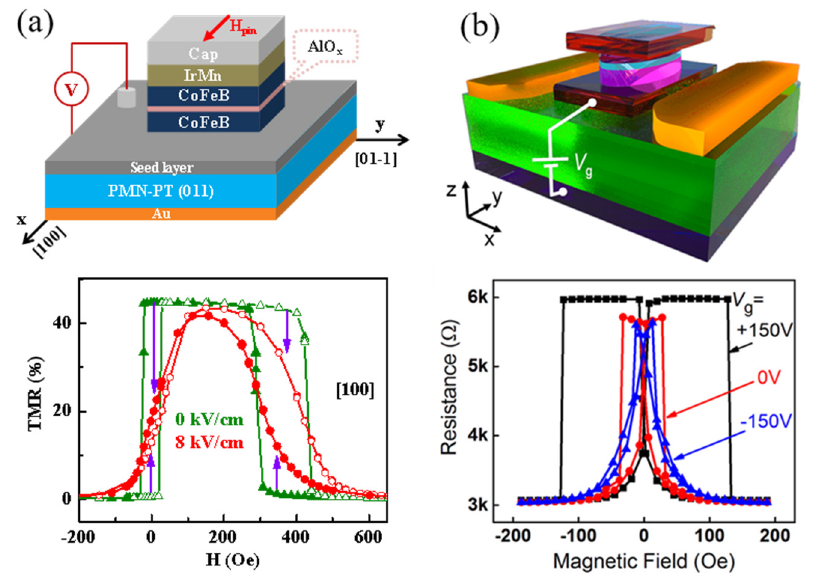
Figure 9. Strain-driven electric-field control of TMR. Volatile electric field manipulation of the resistance in ( a ) AlO x -based MTJ on the (011)-cut PMN–PT and ( b ) MgO-based MTJ on the (001)-cut PMN–PT. The employment of the AFM pinning layer in ( a ) shifts the resistance loop in one magnetic field direction. Reproduced with permission from reference [100,101].